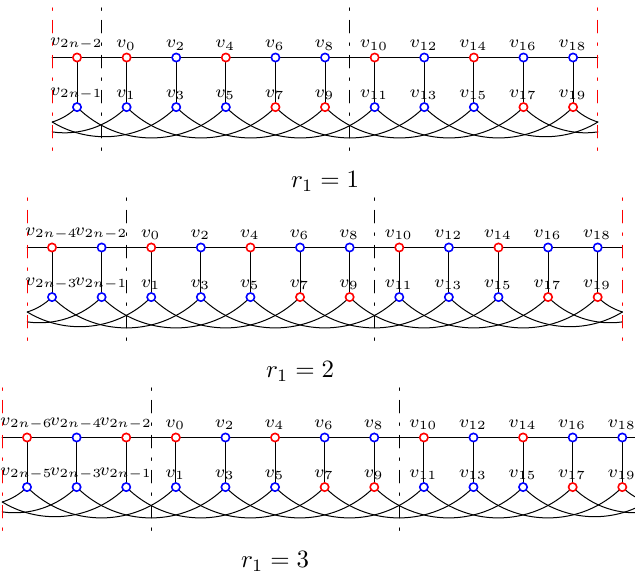
Figure 17. Segments of f in Case 1 in Lemma 10.